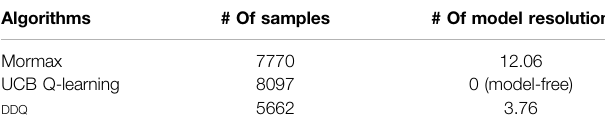
TABLE 2 | The best possible performance on learning MDP M